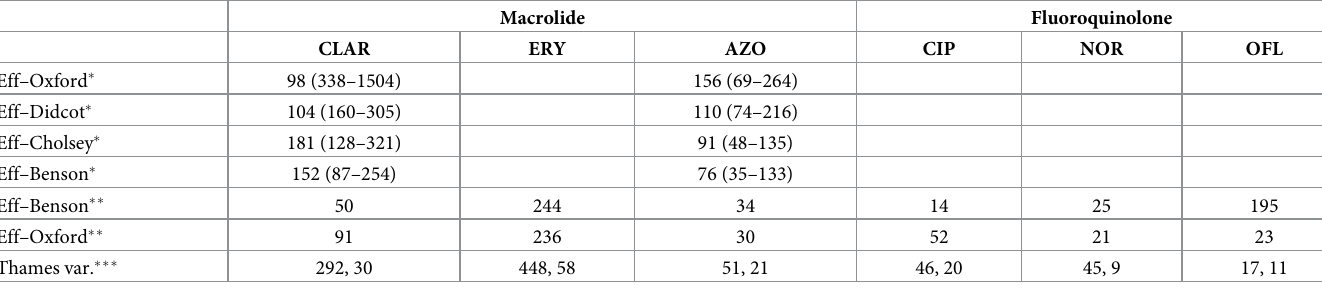
Table 5. Measured antibiotics concentration in STPs and rivers within the Thames Catchment (ng/L) [52].